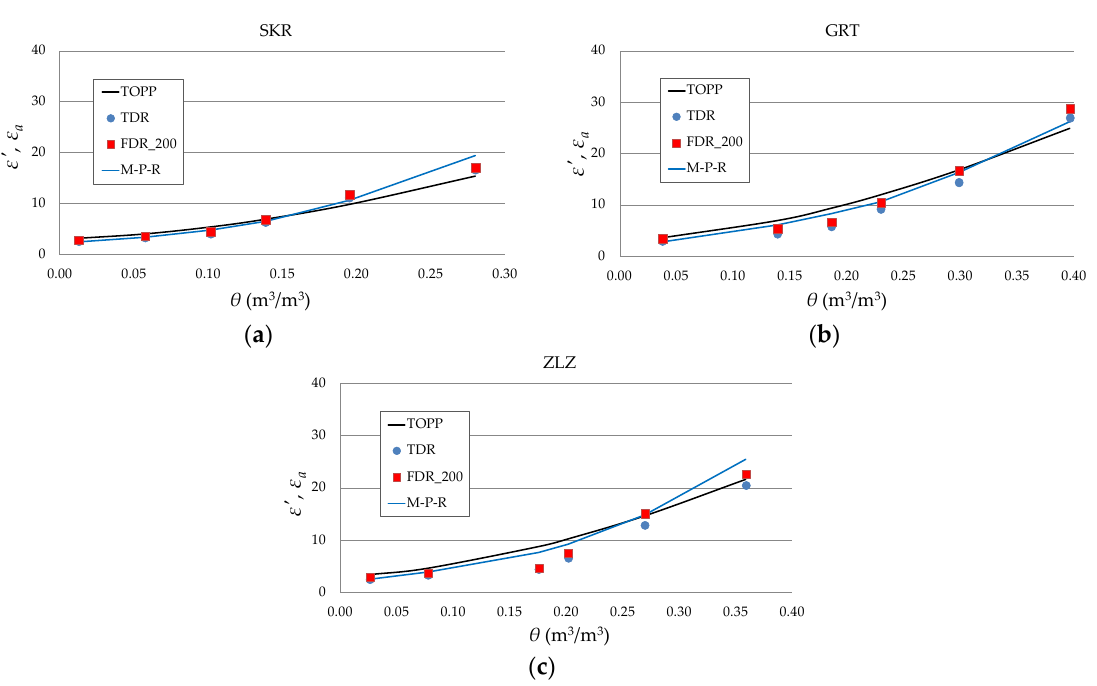
Figure 10. Relations between ε (cid:48) values at 200 MHz. The ε a (data from ADS simulation and the Malicki–Plagge–Roth (M-P-R) equation) and θ values of tested soils (data from measurements using the seven-rod probe and ADS simulations). Black solid lines refer to Topp’s equation and blue solid lines illustrate the M-P-R equation with density correction (Equation ( 2 )).